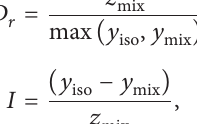
Figure 2: A sketch map on the tidal range and different tidal zones of Chongming Dongtan wetland,